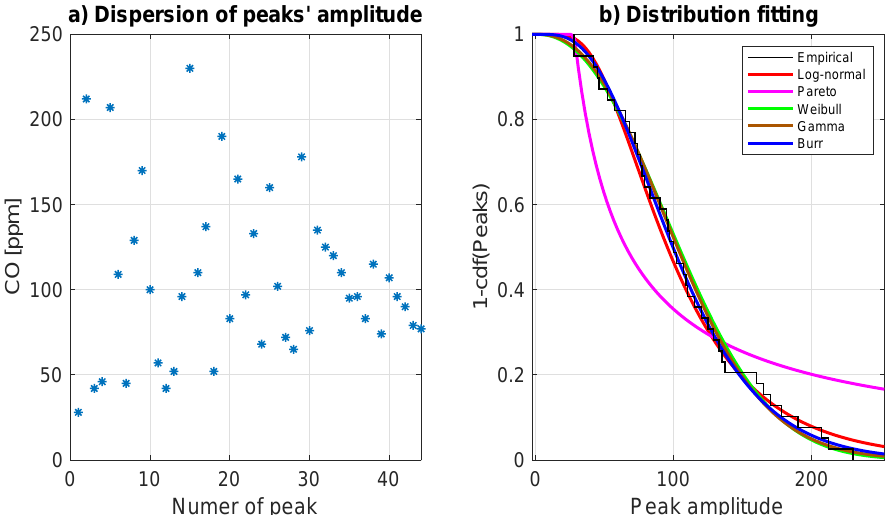
Figure 7. Panel ( a ) shows the dispersion of detected peaks’ amplitudes, whereas panel ( b ) presents the tail of the empirical distribution for peaks’ magnitudes and the theoretical tail of the several fitted